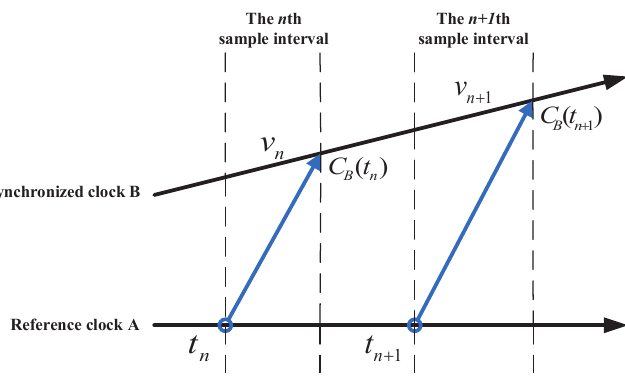
Figure 1. Single-hop Clock Synchronization